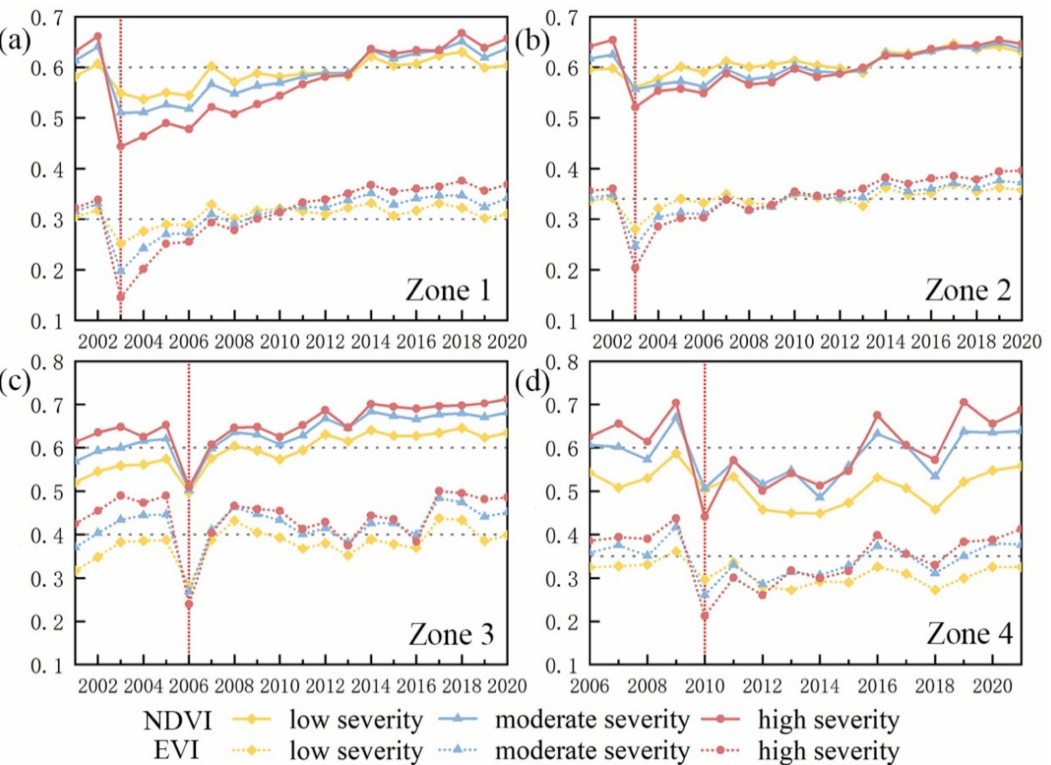
Figure 5. Time series of NDVI and EVI at different fire severities where ( a – d ) represent Zone 1–4. The vertical red dotted line represents the fire year, and the two horizontal grays dashed lines are the mean values of NDVI, and EVI for the three years before the fire, respectively. The three colored solid lines represent NDVI and the dashed lines represent EVI. Yellow lines indicate low severity, blue lines indicate moderate severity, and red lines indicate high severity.